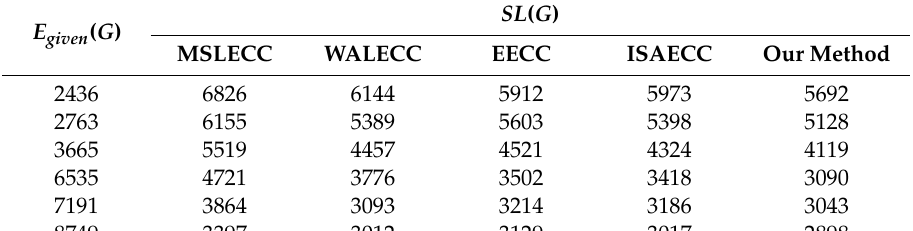
Table 6. Results of GE applications with ρ = 21 for varying E given ( G ) .